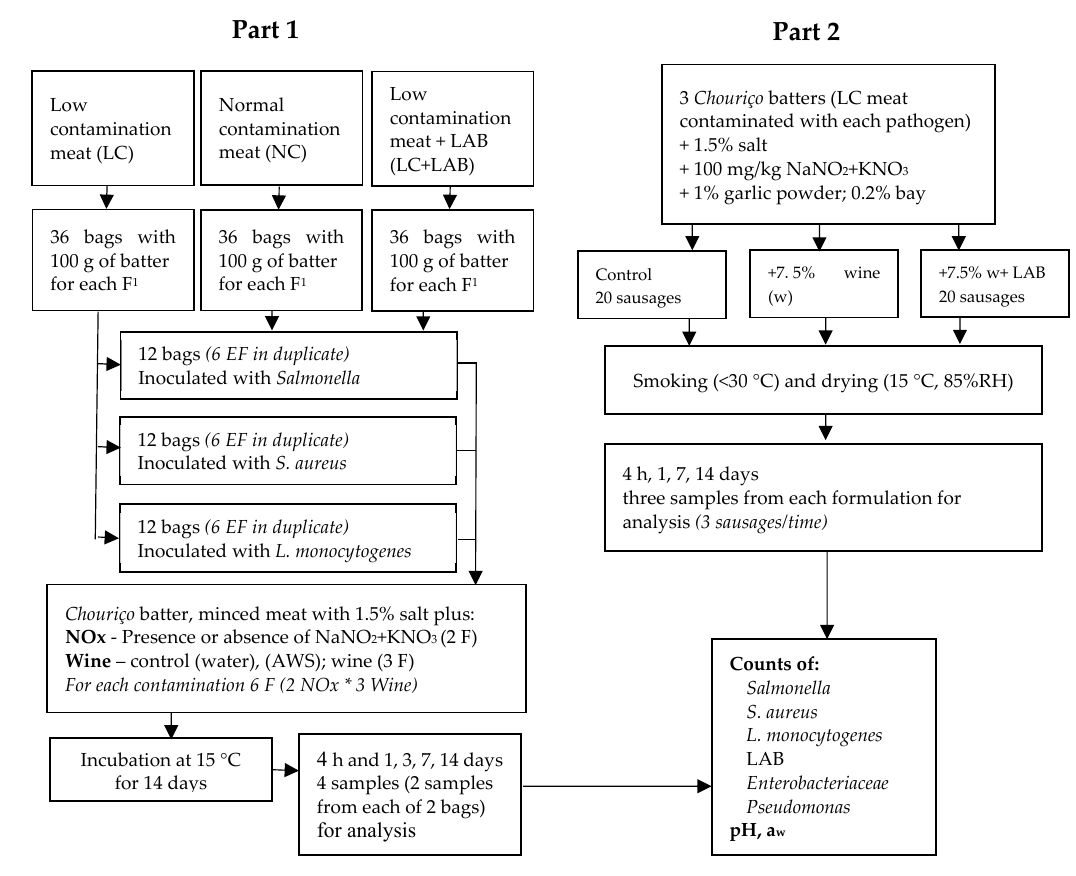
Figure 1. Experimental design. 1 EF Experimental Formulation. Figure. 1. Experimental design. 1 EF Experimental Formulation